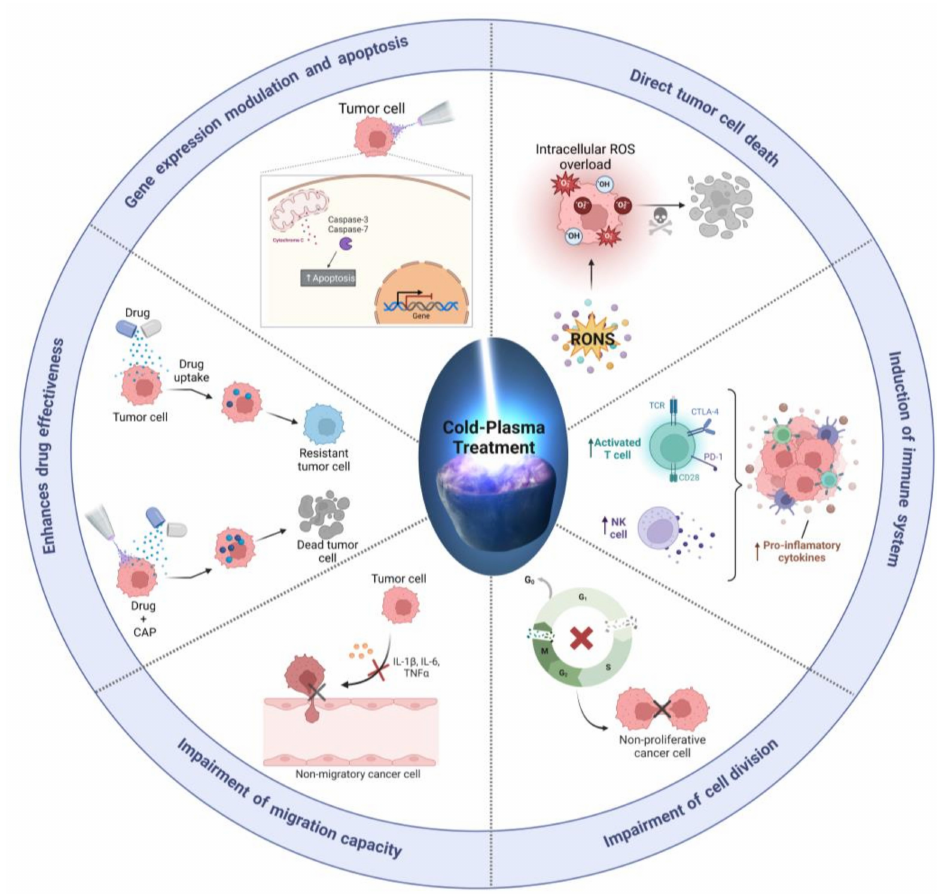
Figure 2. Schematic representation of the main mechanism reported to be induced by CAP in cancer. Briefly, external CAP-derived RONS penetrate the cell membrane by lipid peroxidation, then, intracellular ROS increases. Increase in intracellular ROS may induce DNA damage, impair cell division, migration, inducing the translocation of the cytochrome c and activation of apoptosis. The increase in RONS can also induce the activation of immune system to target tumor cells or enhance the effectiveness of chemotherapeutic drugs. Figure created using BioRender.com and DALL.E-2 (Accessed on 22 December 2022;